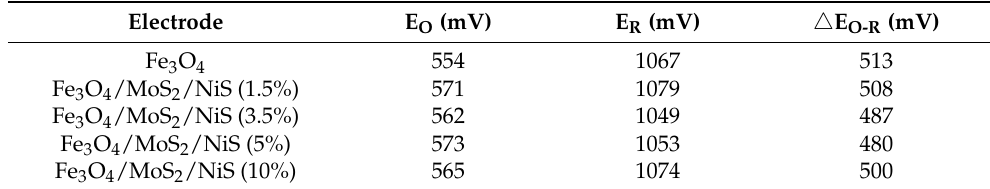
Figure 6. ( a – e ) Cyclic voltammetry curves of the Fe 3 O 4 , Fe 3 O 4 /MoS 2 /NiS (1.5%), Fe 3 O 4 /MoS 2 /NiS (3.5%), Fe 3 O 4 /MoS 2 /NiS (5%), and Fe 3 O 4 /MoS 2 /NiS (10%) electrodes; ( f ) Plots of the relationships between the maximum oxidation peak currents and the square root of the scanning speeds. Table 1. Anode and cathode potentials and potential differences of five sample